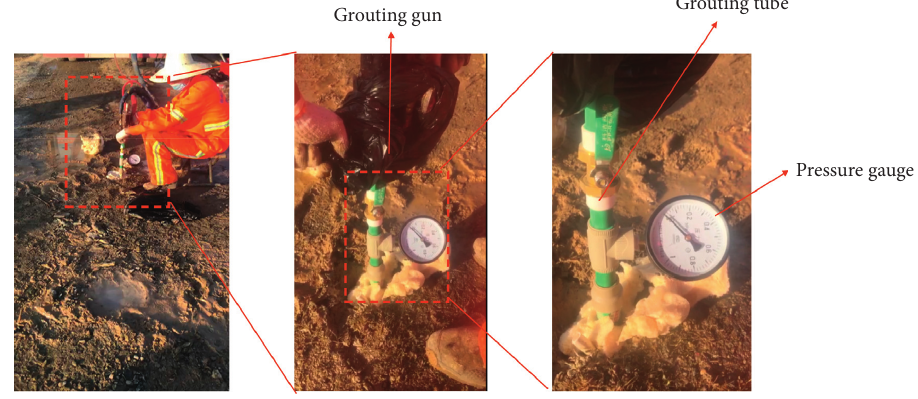
Figure 18: In situ grouting.